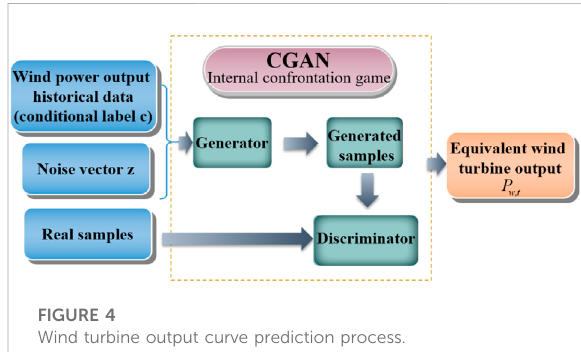
FIGURE 4 Wind turbine output curve prediction